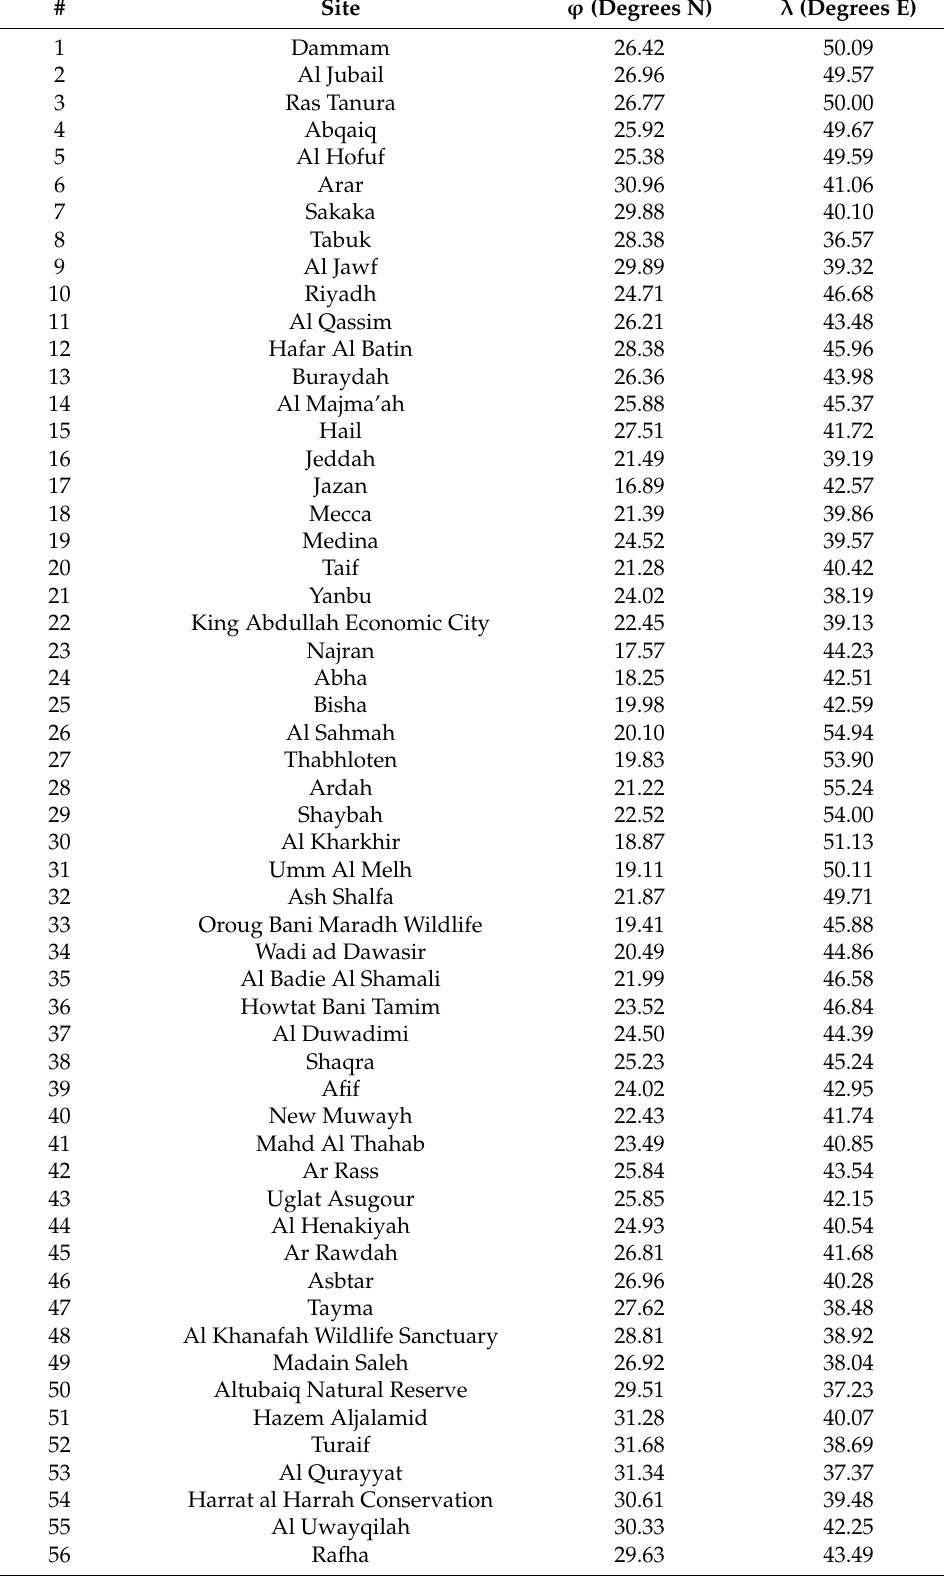
Table 1. The 82 sites selected over Saudi Arabia to cover the whole territory of the country; ϕ is the geographical latitude, and λ the geographical longitude in the WGS84 geodetic system. This table is reproduction of Table 1 in